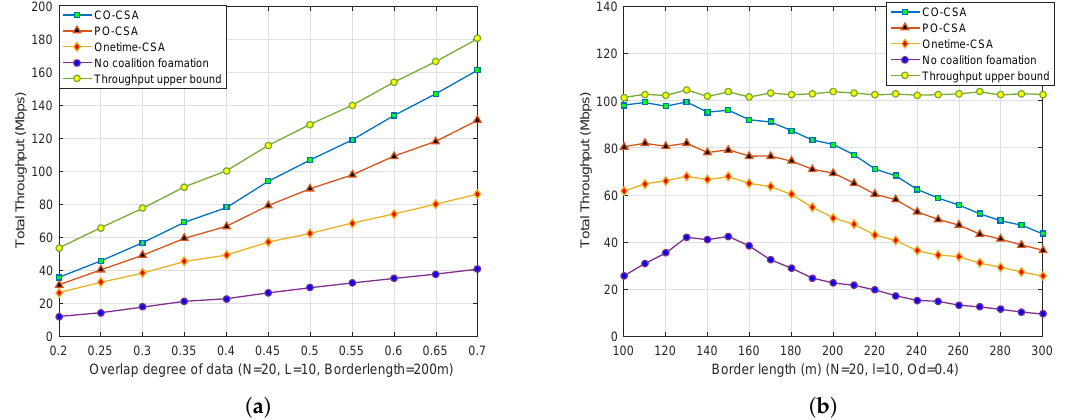
Figure 5. Performance comparison of algorithms based on ( a ) data overlap degree and ( b ) border length of